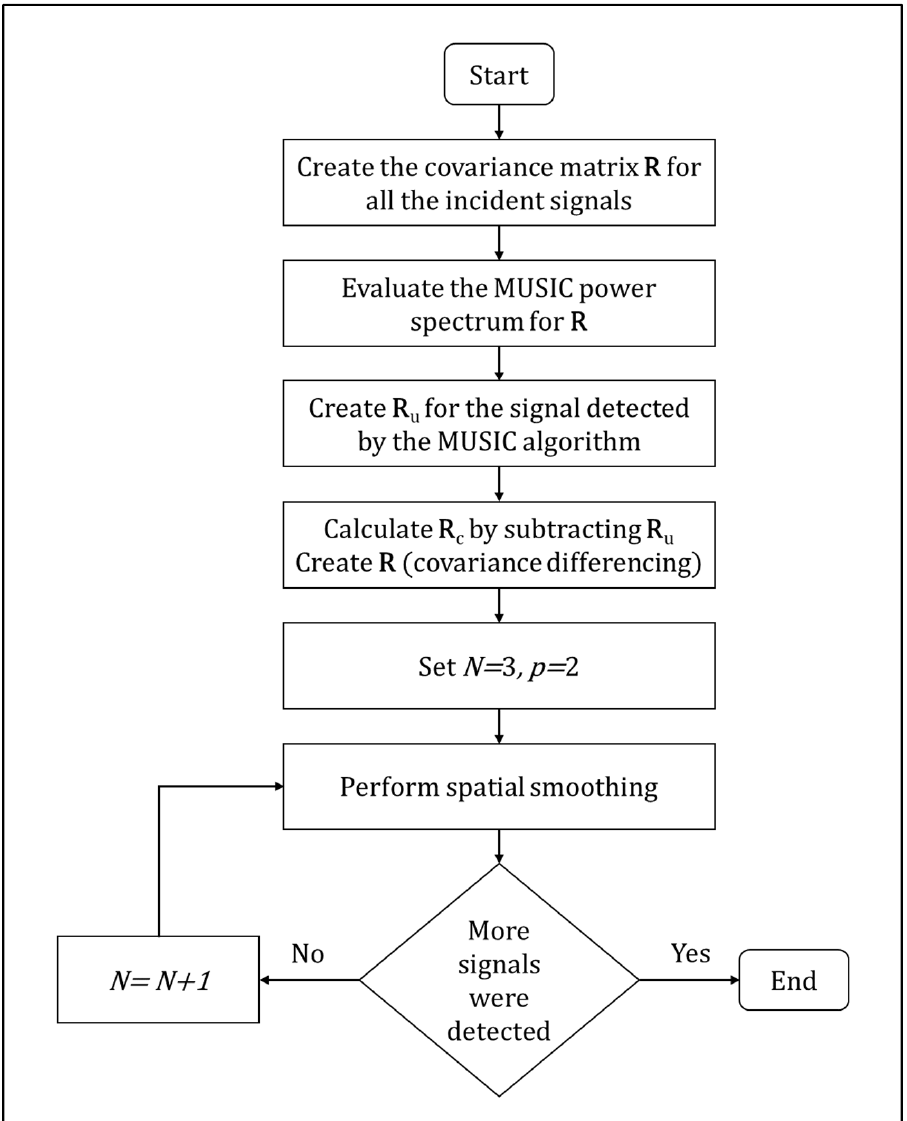
Figure 1. MUSIC algorithm carried out in the paper for detecting and separating peaks for close signals.